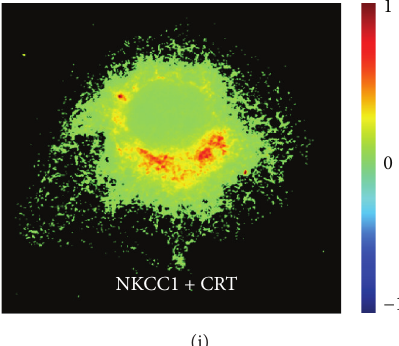
Figure 5: NKCC1 localizes in the ER of COS7 cells. ((a)-(b)) Representative image of COS7 cells immunolabeled against NKCC1 using T4 (a) or calreticulin (CRT, (b)) antibodies and developed using fluorescently labeled secondary antibodies: Cy3 (NKCC1, red) and FITC (CRT, green). (c) Overlay of (a) and (b). Pictures were superimposed to obtain an image where colocalization could be digitally estimated as yellow pixels (red + green = yellow). Scale bar represents 10 𝜇 m. (d) Semiquantitation of red, green, and yellow pixels corresponding to NKCC1, CRT, and NKCC1 + CRT, respectively. Shown are the results obtained from at least 10 cells and represented as mean fluorescence intensity in arbitraryunits ± SEM.(e)Colocalizationheat-mapofthesquaredcellin(c)computedbyusingNIH ImageJ .((f)-(g))Shownarerepresentative images of COS7 cells grown in the presence of cycloheximide (1 𝜇 g/mL) to acutely inhibit protein synthesis and deplete endogenous NKCC1 from the ER. The presence of NKCC1 (f) or CRT (g) was codetected by using the relevant primary antibodies and developed using secondary antibodies labeled with Cy3 (red) or FITC (green) fluorophores. (h) Superimposition of (f) and (g) images to estimate colocalization as heat-maps, as shown in